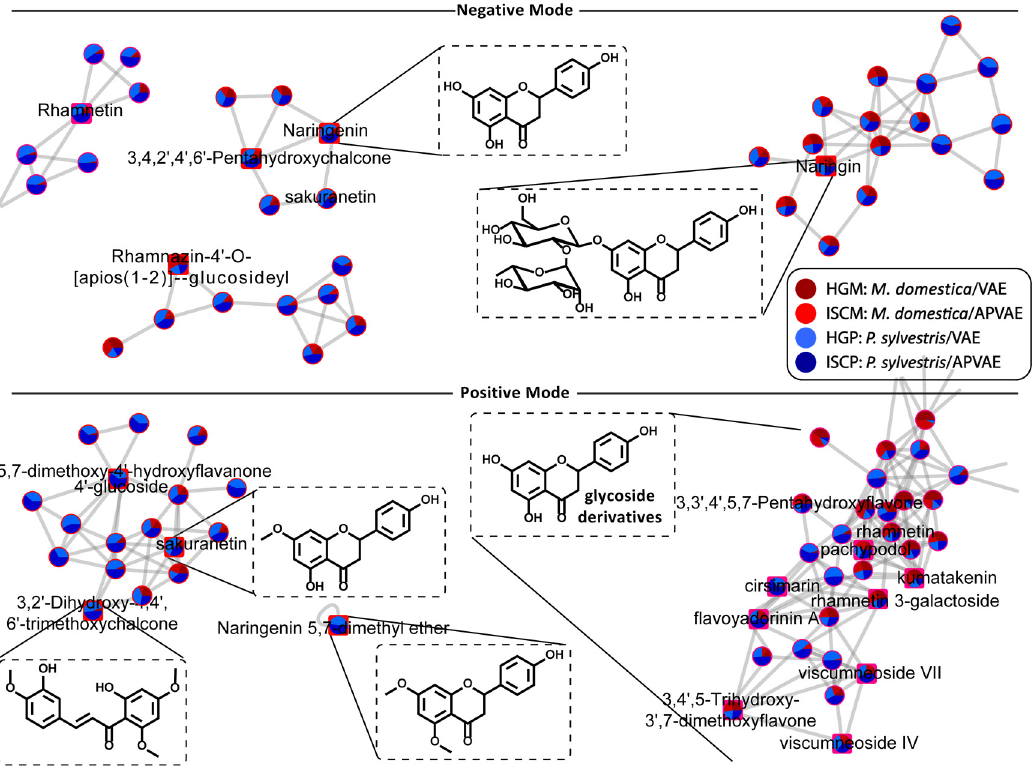
Figure 6. Nodes from the molecular network related to flavonoid structures obtained from fermented aqueous extracts of V. album. Molecules 2020 , 25 , x FOR PEER REVIEW 10 of 15